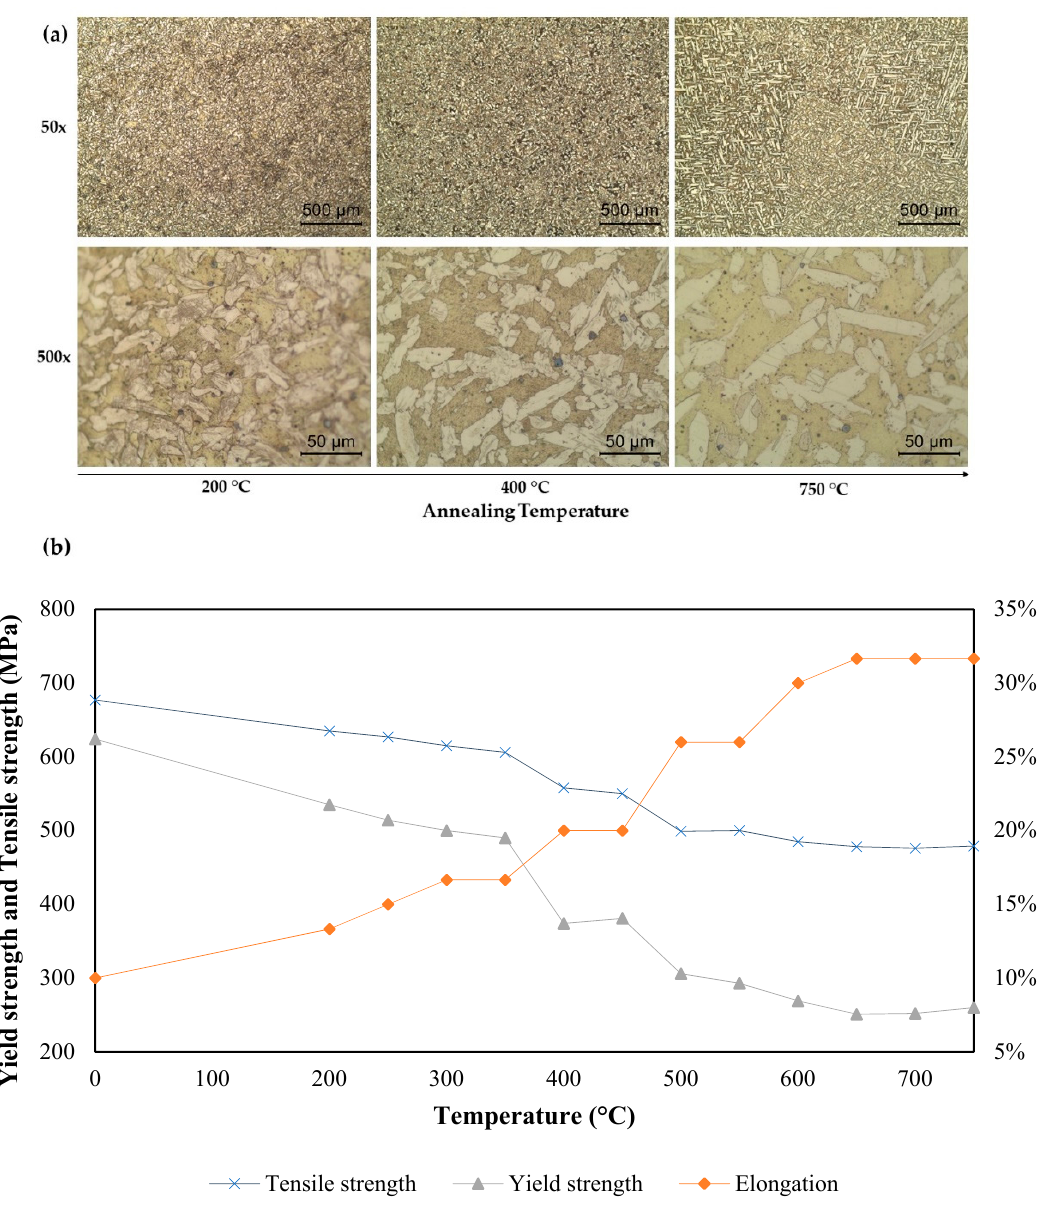
Figure 8. Effect of temperature during heat treatment ( a ) in the sample microstructures at 200, 400, and 750 °C, respectively, in the columns from left to right, ( b ) the mechanical properties accordingly from each applied temperature.